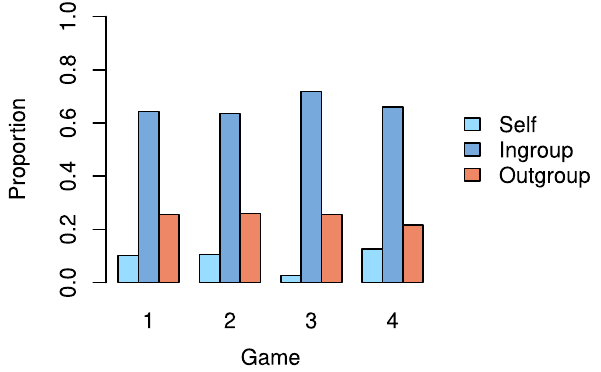
Figure 3. Proportion of tokens received from ingroup, outgroup and self in each game.